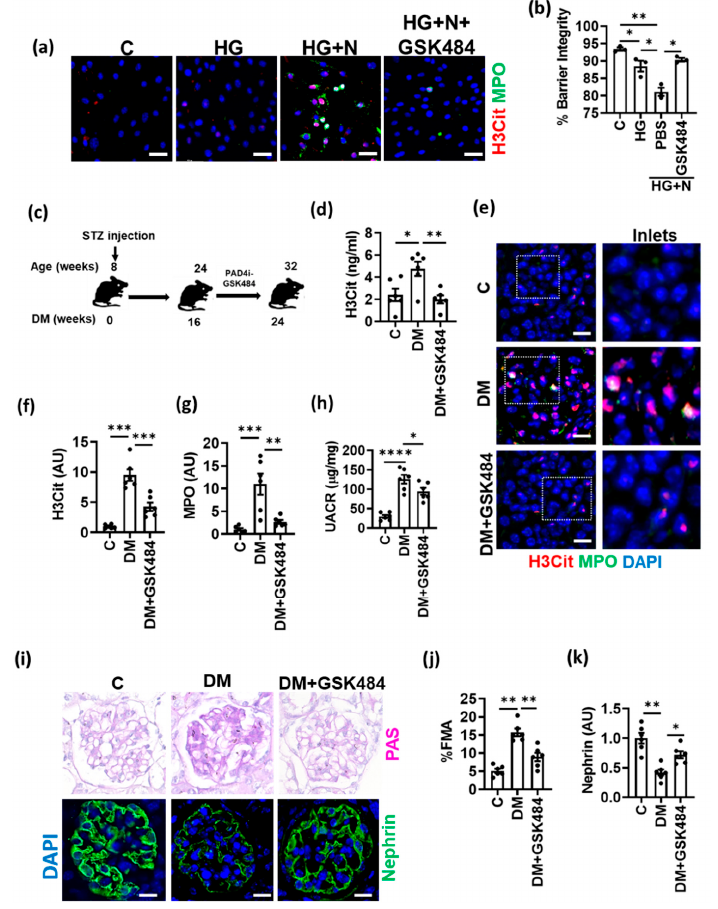
Figure 3. PAD4 inhibition ameliorates NET formation and experimental DKD. ( a ) Representative immunocytochemical images for NET markers MPO (green) and H3Cit (red) on mGENCs exposed to high glucose alone (HG, 25 mM), HG and neutrophils without (HG+N) or with the PAD4 inhibitor GSK484 (HG+N+GSK484) compared to control (C, 5 mM glucose, not neutrophils) mGENCs. ( b ) Bar graph summarizing barrier integrity of the in vitro GFB model. Effect of GSK484 ‐ mediated NET inhibition in the presence of high glucose and neutrophils (HG+N+GSK484) compared to control (C), high glucose alone (HG), or HG+N stimulation without GSK484 (PBS). ( c ) Schematic representation of experimental approach of treatment with the PAD4 ‐ inhibitor (PAD4i) GSK484 in type ‐ 1 diabetic mice (streptozotocin model, STZ) after 16 weeks of established hyperglycemia. ( d – g ) Plasma NET markers (( d ), ELISA, bar graph summarizing results) and NET markers in glomeruli (( e ), representative immunostaining for H3Cit, red and MPO, green; ( f , g ), bar graph summarizing results) in non ‐ diabetic control (C) and diabetic mice without (DM) or with (DM+GSK484)